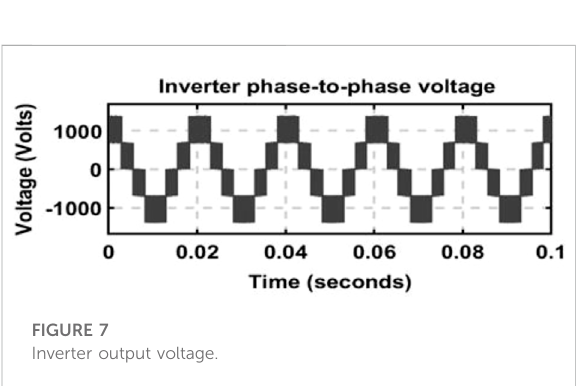
FIGURE 7 Inverter output